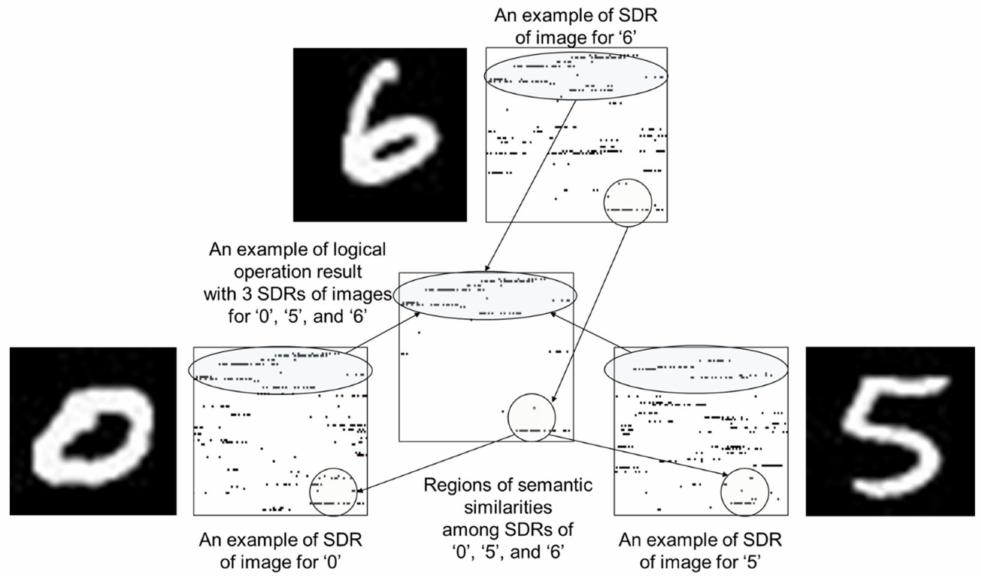
Figure 7. Concept of the proposed morphological semantic preservation scheme based on the idea of Cortical.IO. The regions of semantic similarities among SDRs of images ‘0’, ‘5’, and ‘6’ are indicated with